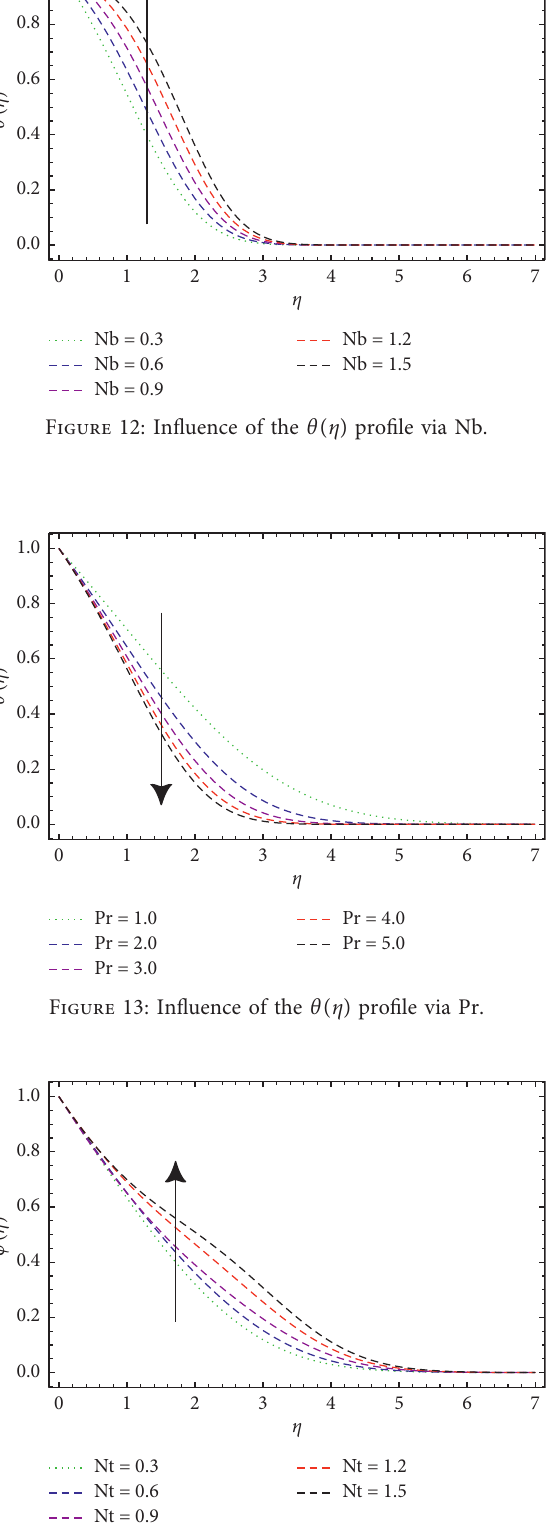
Figure 14: Influence of the temperature ϕ ( η ) profile via